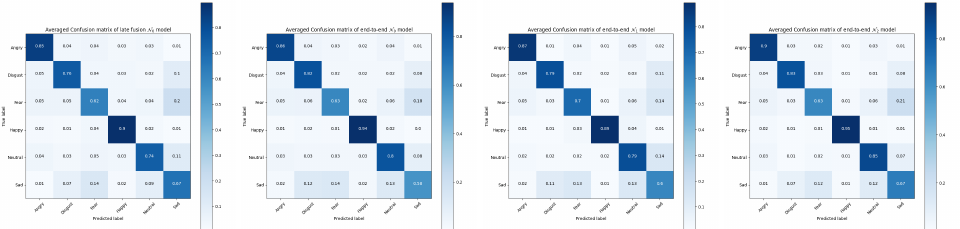
Figure 10. Averaged confusion matrices of tested models for RAVDESS dataset.